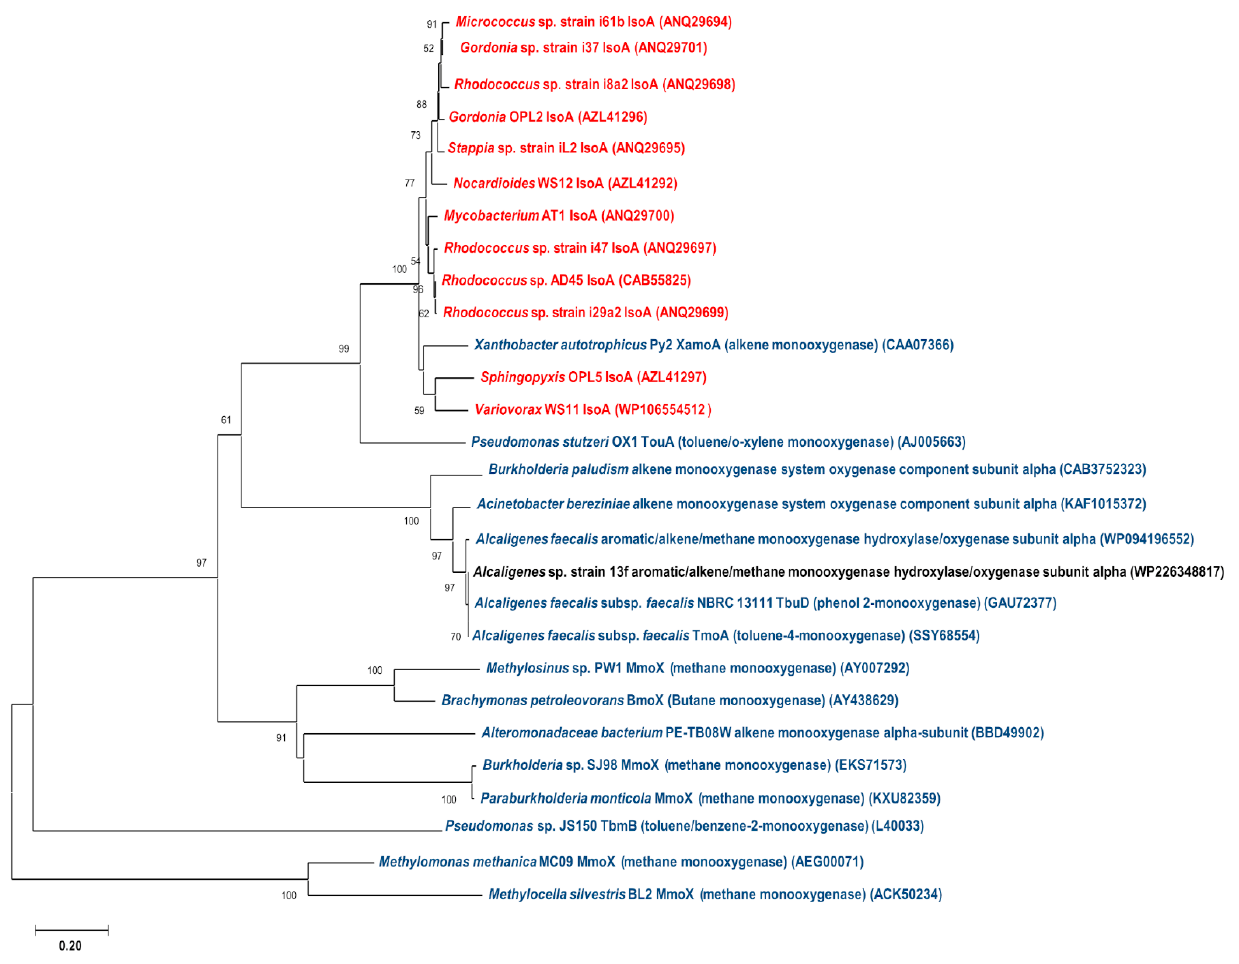
Figure 5. A phylogenetic tree demonstrating the similarities among the IsoA amino acid sequences of known isoprene-degrading strains (red), monooxygenase of Alcaligenes sp. strain 13f (black), and other hydrocarbon monooxygenases of other bacteria (blue). A tree was constructed through the maximum composite likelihood model of neighbour-joining method with 1000 bootstrap